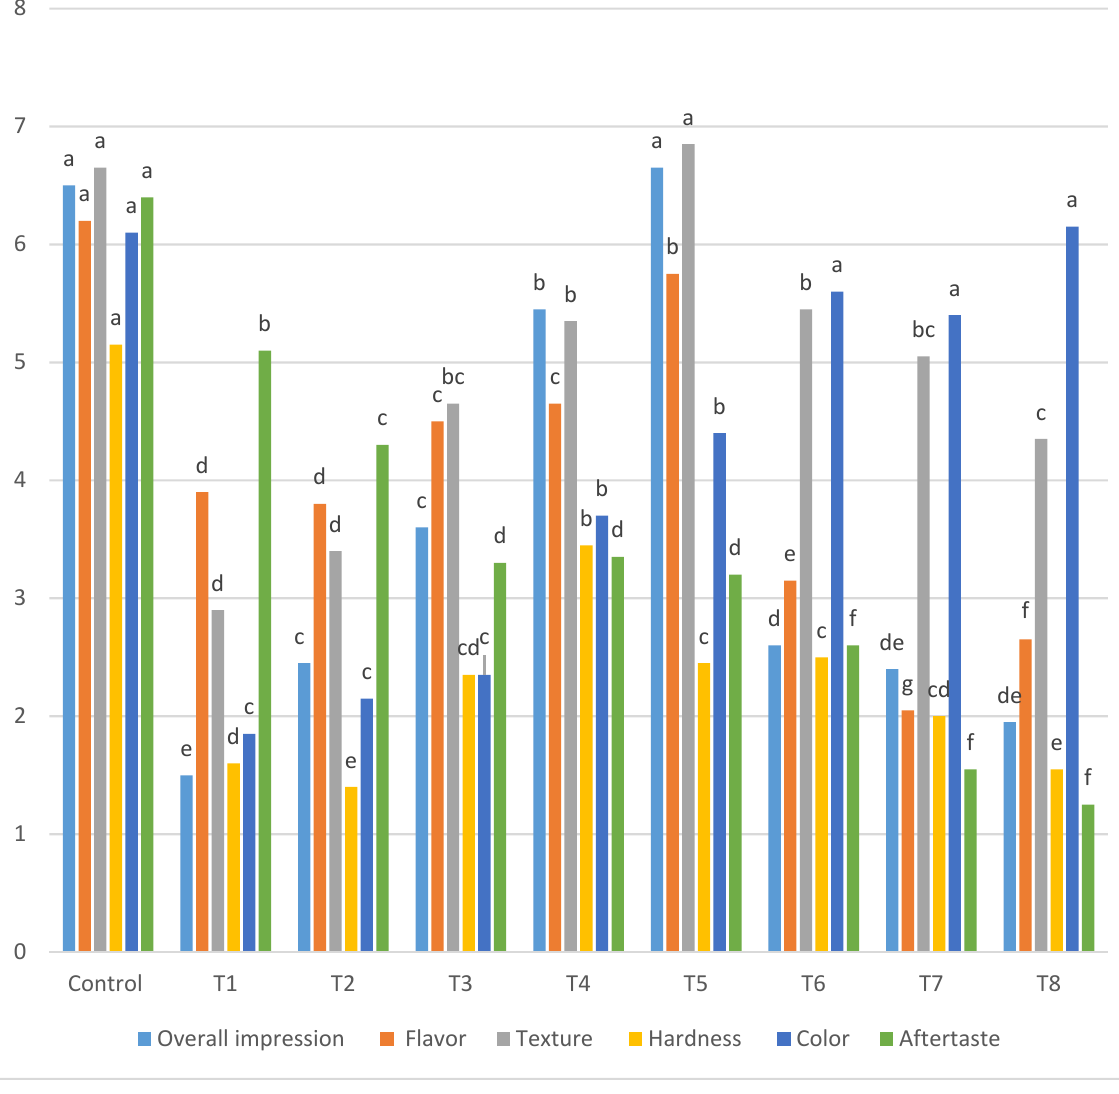
Figure 3. Sensory evaluation (overall impression, flavor, texture, hardness, color and aftertaste) for gluten-free cinnamon roll treatments and control (100% wheat flour); T1–T8 are presented by 85:5, 80:10, 75:15, 70:20, 65:25, 60:30, 55:35 and 50:40 as % of resistant starch to lupin in the presence of 10% flaxseed flour for all the treatments. Column values with the same letters were not significantly different ( p ≤ 0.05). Means with different letters in the same column are significant at ( p ≤ 0.05).